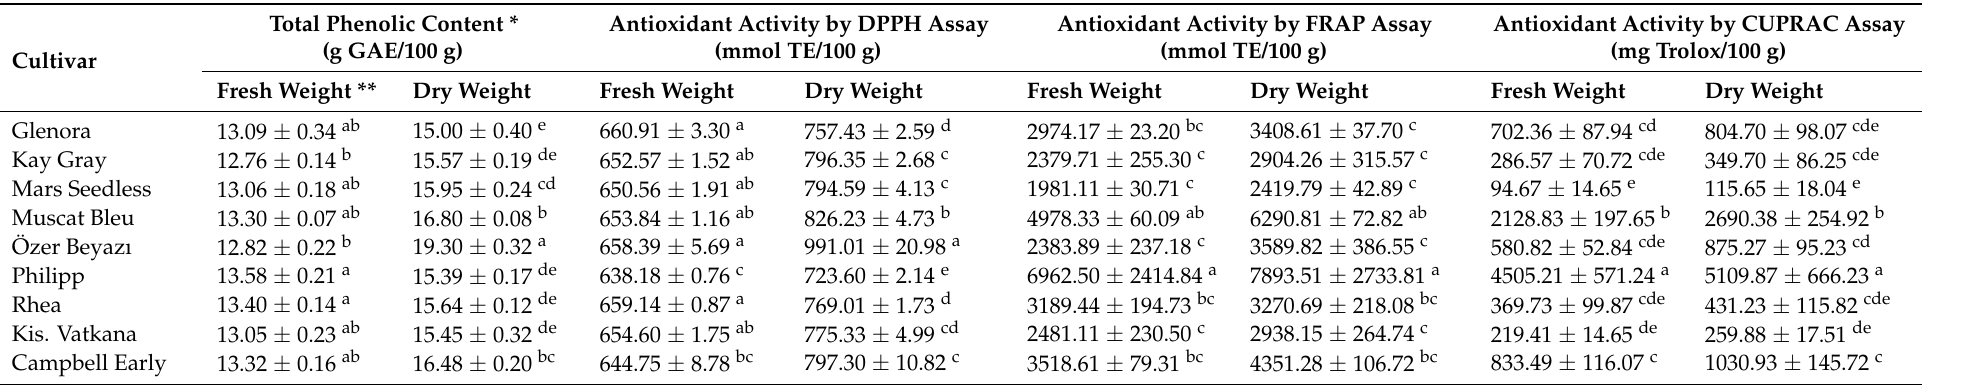
Table A2. Bioactive contents of raisins from different grape